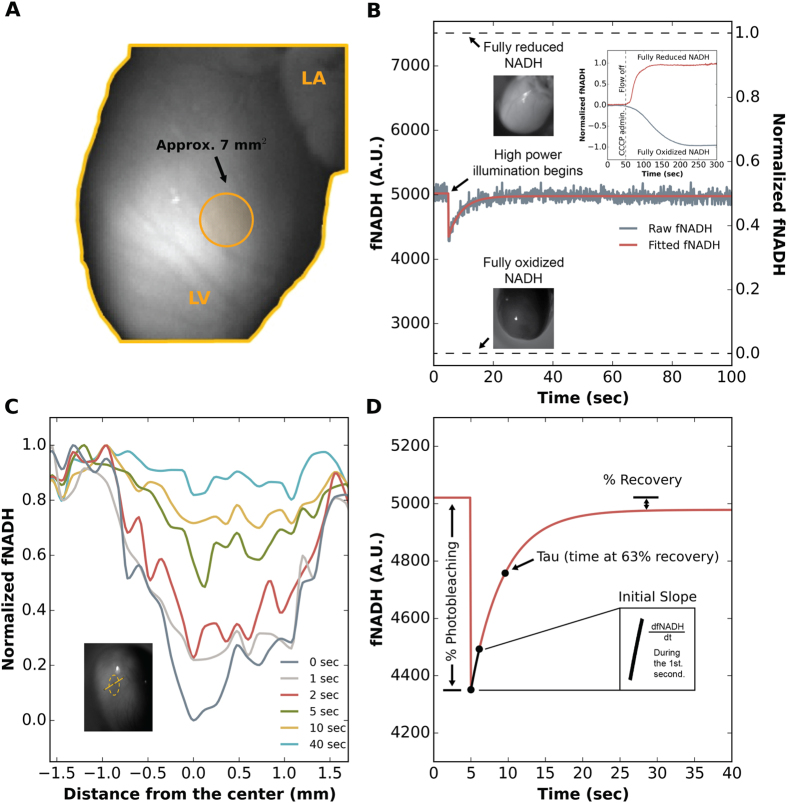
(A) Photobleaching UV light was focused on the LV epicardium within an area of ~7 mm2 (orange circle) and delivered as one of four modes (Table 1). (B) A typical NADH ED-FRAP signal is plotted within the range of the estimated total NADH pool. The application of 23.8 mJ of photobleaching energy typically lowered baseline fNADH by 13.2 ± 2.3%. Inset: Normalized fNADH signals are shown for one heart during full reduction (global ischemia at t = 50 sec) and for another heart during full oxidation (CCCP administered at t = 50 sec). The non-normalized signals were used to estimate the total NADH pool. (C) An example of spatial fNADH recovery profiles from 0 to 40 sec after photobleaching the area shown in the fNADH image (yellow dotted line). Within 40 sec the spatial fNADH profile returned to baseline levels and was indistinguishable from the fNADH of surrounding unbleached tissue. (D) Measurements extracted from NADH ED-FRAP signals: (1) Percent photobleaching was measured from baseline (fNADH at t < 5 sec) to the maximum fNADH drop (fNADH at t = 5 sec); (2) Percent recovery was measured from baseline to the steady-state fNADH recovery value; (3) Recovery time constant tau was measured as the time to 63% of full fNADH recovery; (4) The initial slope of recovery was measured as the straight-line slope of change in fNADH during the first second of recovery.